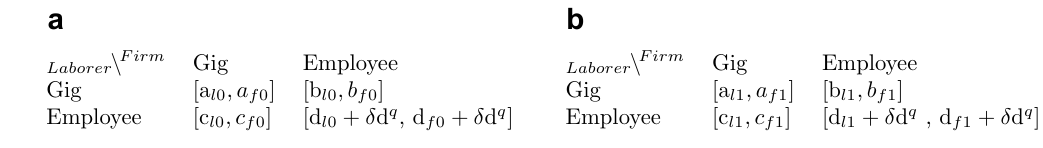
Figure 6: High Employee Payo↵, Matrix Operation Figure 12. High employee payoff, matrix operation. ( a ) High employee payoff, n = 0; ( b ) high employee payoff, n =